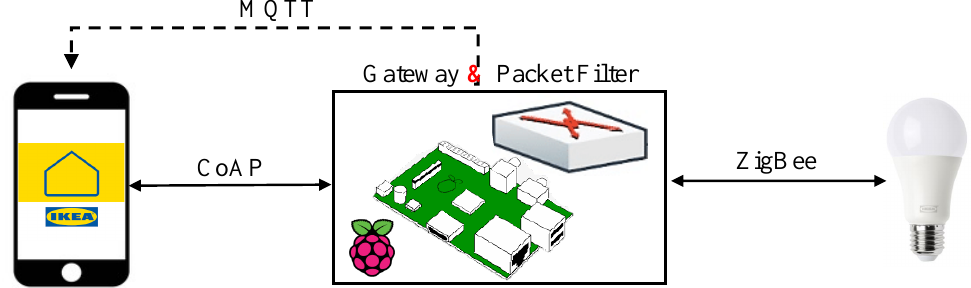
Figure 9. DoS attack countermeasure